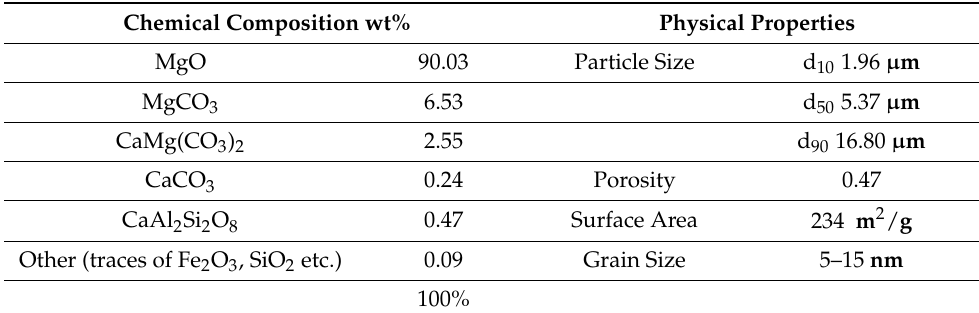
Table 1. Physical properties of MgO porous micron-sized